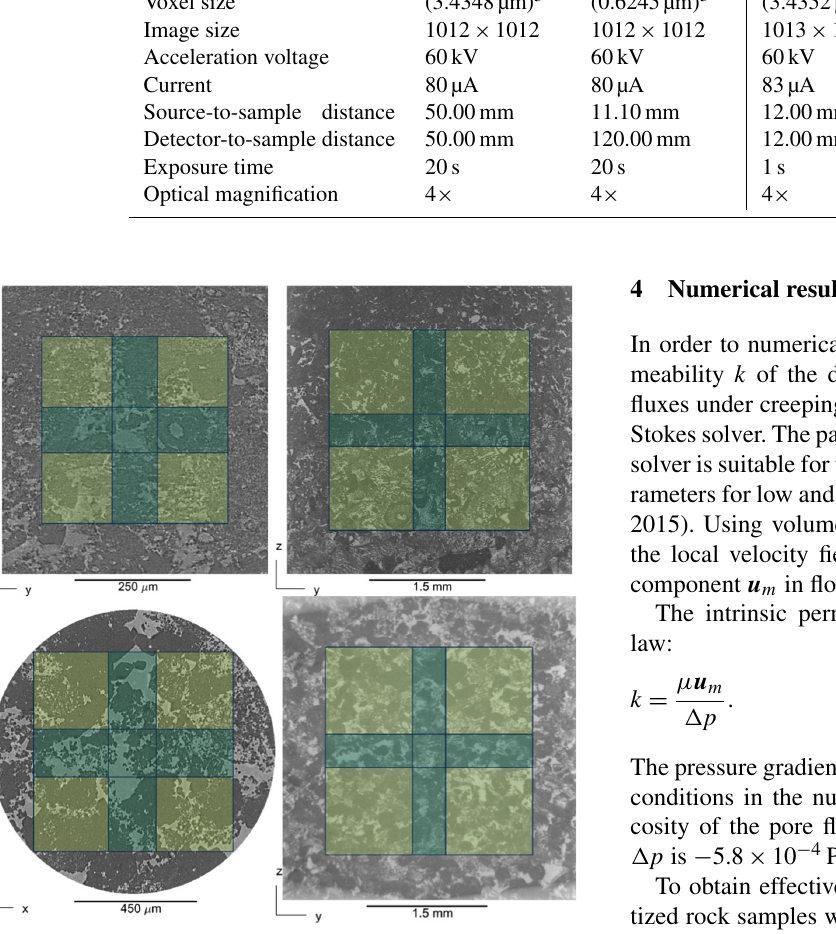
Figure 4. Slices of the raw tiff images of the scanned samples. The dark green areas mark the overlapping zones of the consid- ered subvolumes. Top row: Carb-A with high (left) and low resolu- tion (right). Bottom row: Carb-B with high (left) and low resolution